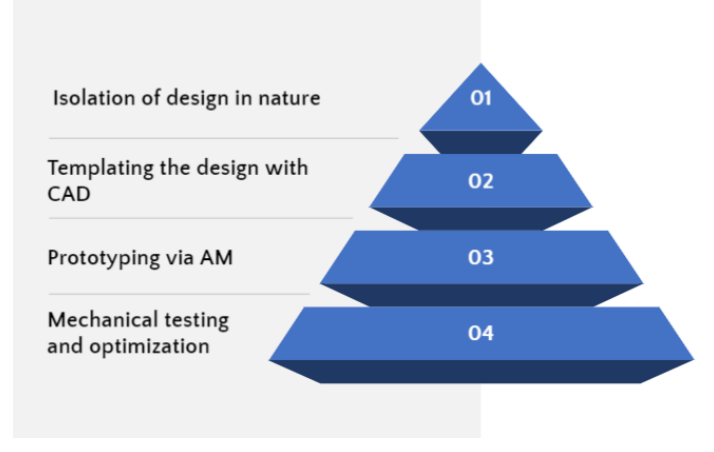
Figure 8. Additive Manufacturing Methods [28]